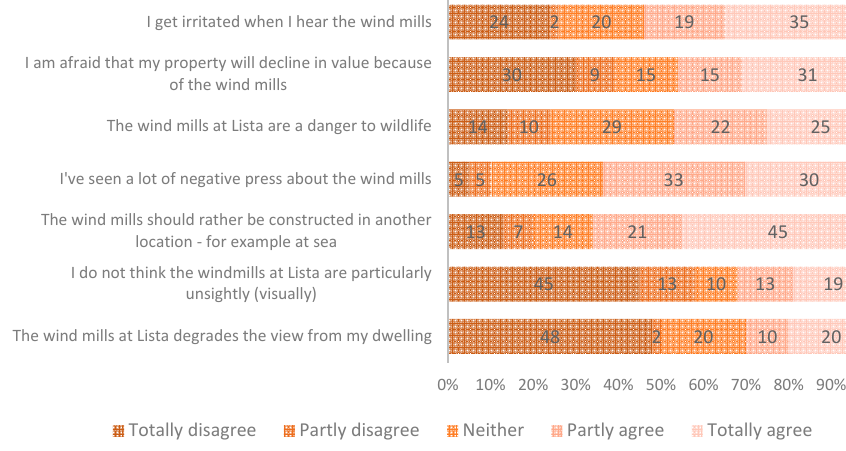
Figure 5. Respondents who agree or disagree to a set of prepared opinion statements. Local (Lista) context. n = 90.